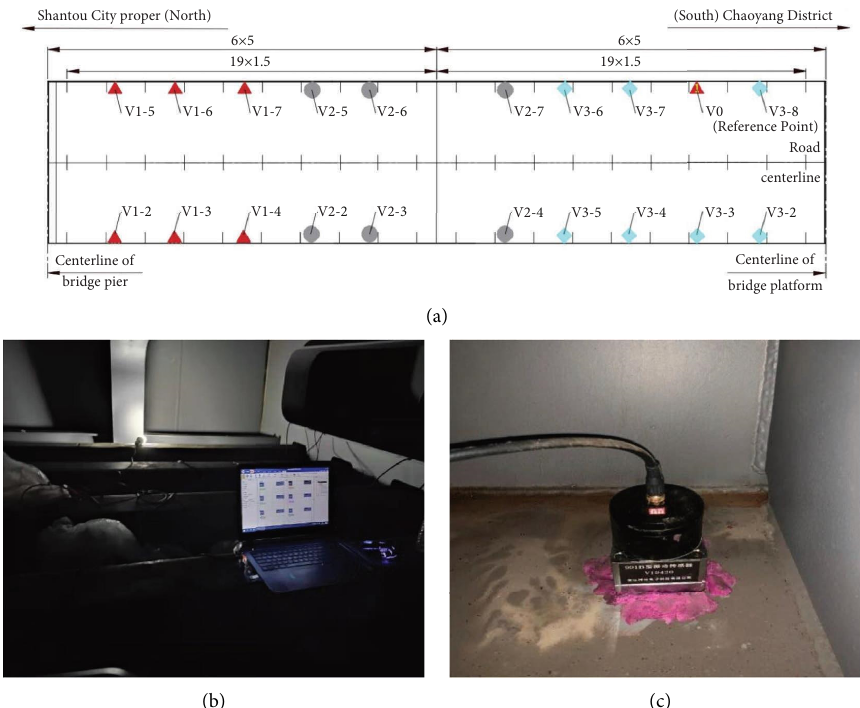
Figure 4: Test arrangement. (a) Vertical sensor arrangement (unit: m). (b) Data acquisition system in the steel box girder. (c) 991B acceleration